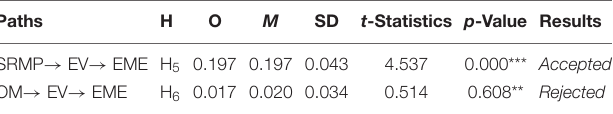
TABLE 7 | Indirect effects of the variable.